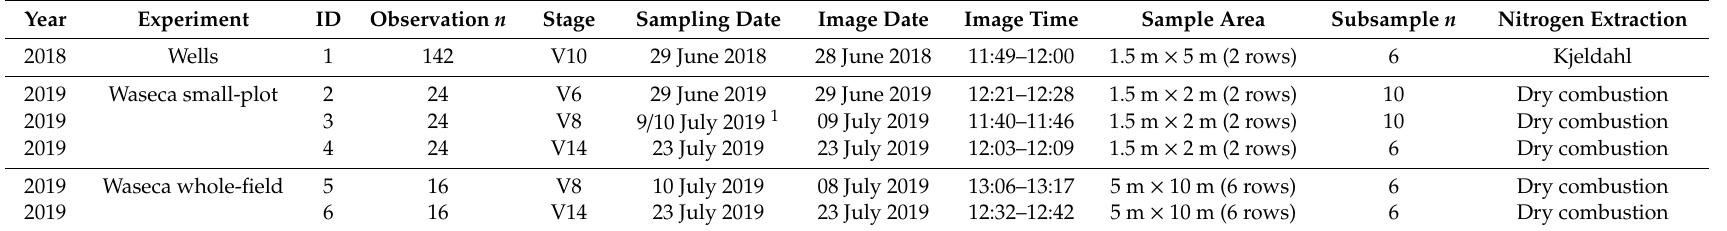
Table A1. Number of experimental observations ( n ), tissue sampling date, image acquisition date and local time, sampling area, number of tissue subsamples, and nitrogen extraction method for each experimental dataset subset by vegetative development stage.